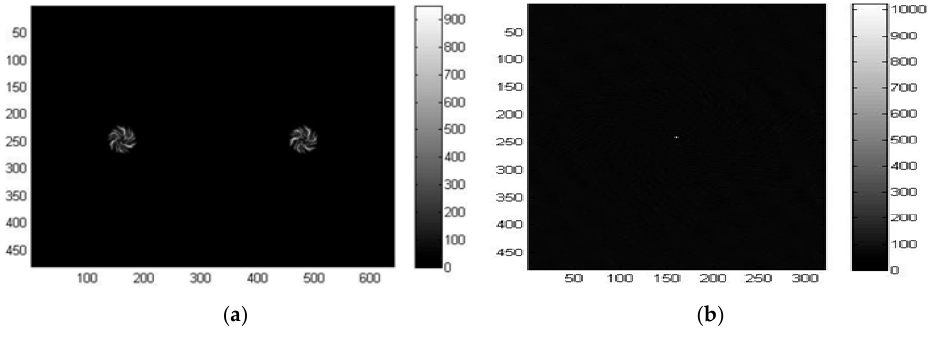
Figure 6. ( a ) Reference point-spread function (PSF); ( b ) reconstructed point.